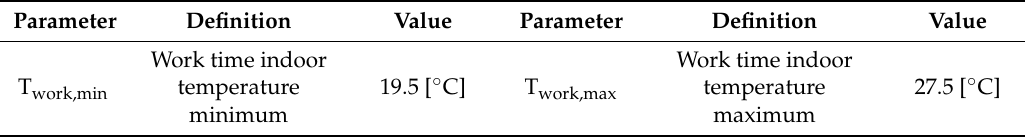
Table 6. Indoor temperature constraints between 2:00 p.m. and 3:00